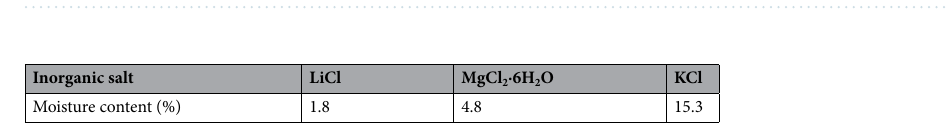
Figure 2. Change in yield of 5-HMF with treatment time for dried wood treated (0.09 g) in [MIM]HSO 4 (3 g) at 160 °C.